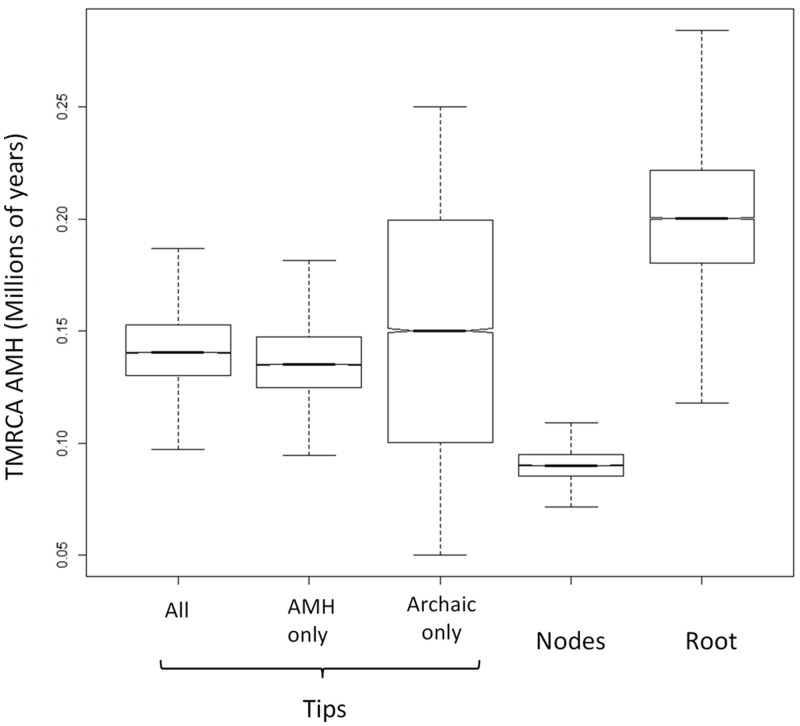
Estimates of the TMRCA of all AMHs. Box plot (minimum, quartiles, median, and maximum) for Bayesian estimates of the TMRCA of all modern humans (in Ma) obtained under various calibration scenarios.